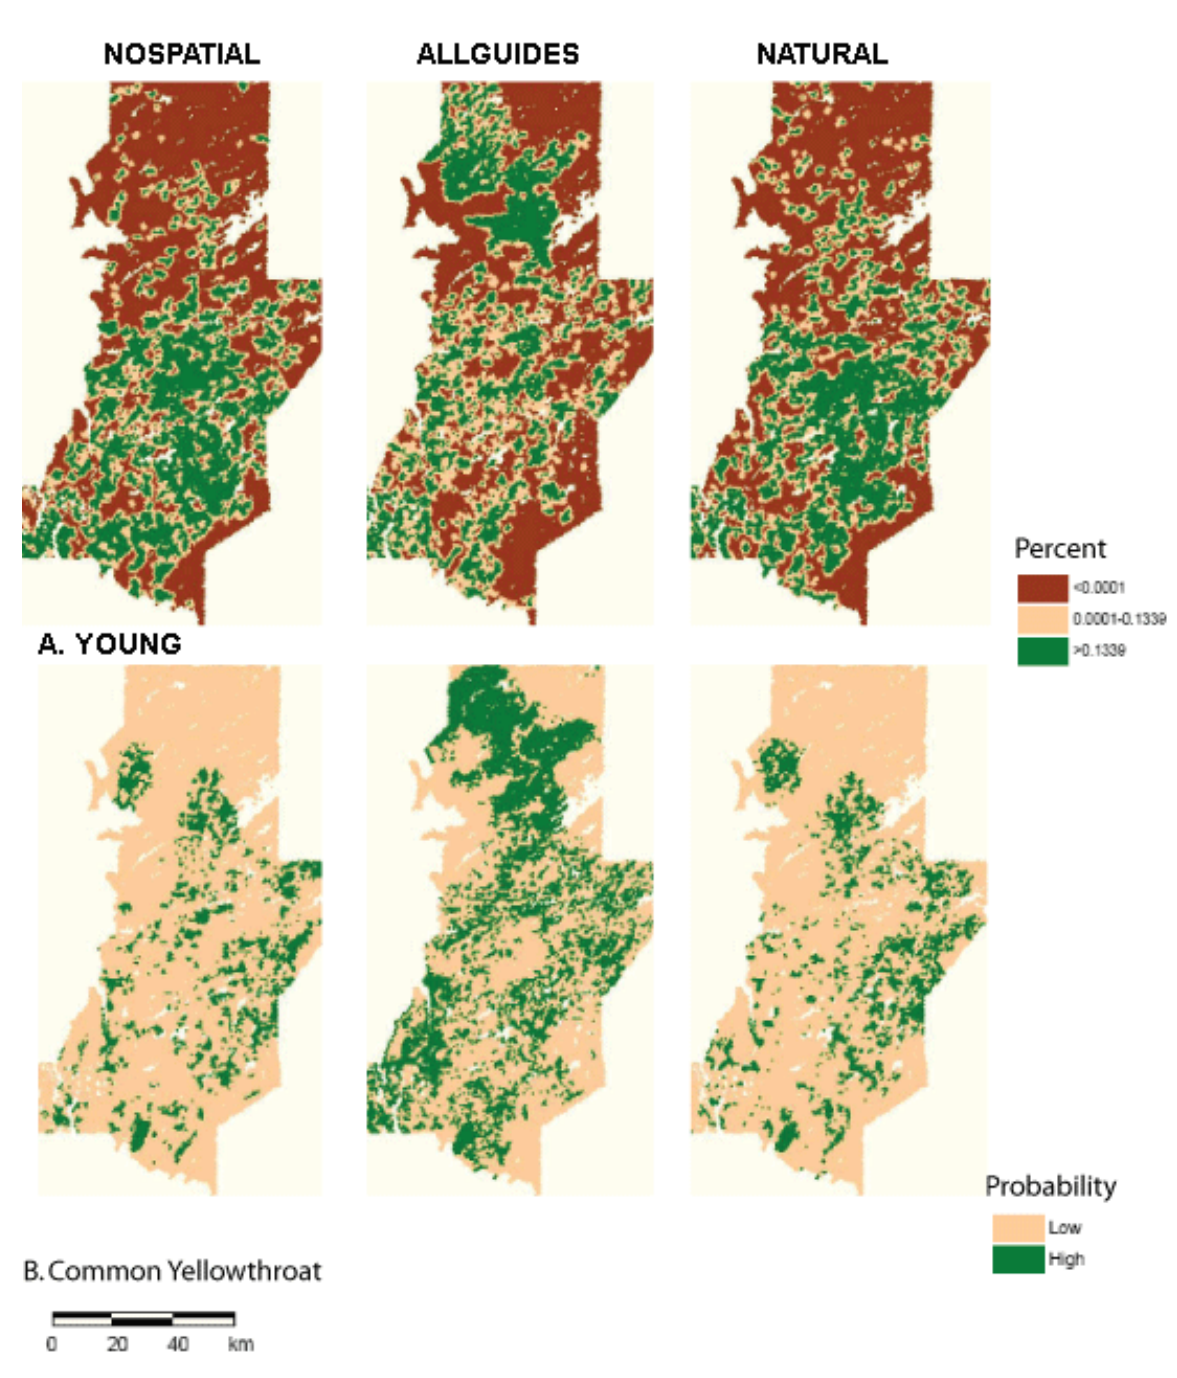
Fig. 13. Change in spatial pattern of young forest (YOUNG) at the local scale, and the probability of habitat occupancy for Common Yellowthroat, under scenarios NOSPATIAL, ALLGUIDES, and NATURAL at year